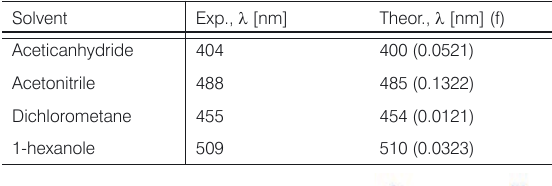
Table 1. Experimental and theoretical electronic spectra in different solvents.